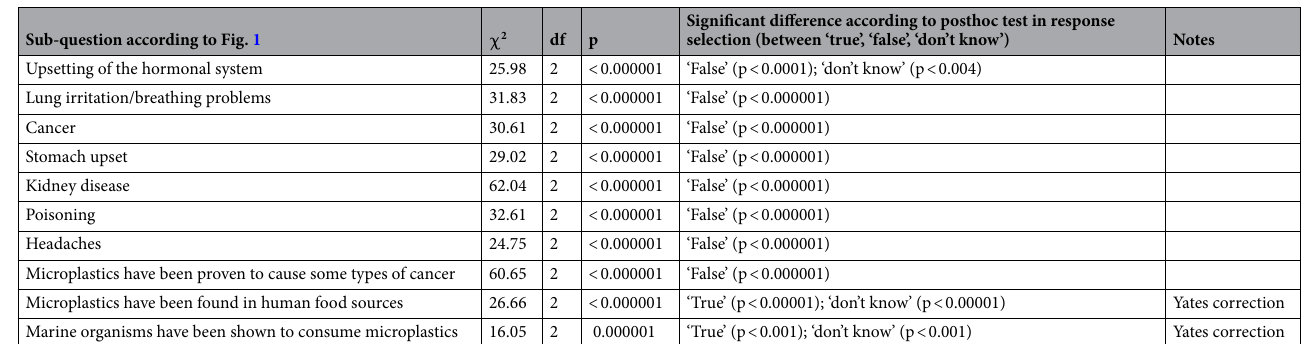
Table 2. Results of between group (lay/experienced) χ 2 test and subsequent posthoc (residual chi-square) test to questions posed in Fig. 1. Bonferroni-adjusted p-value of